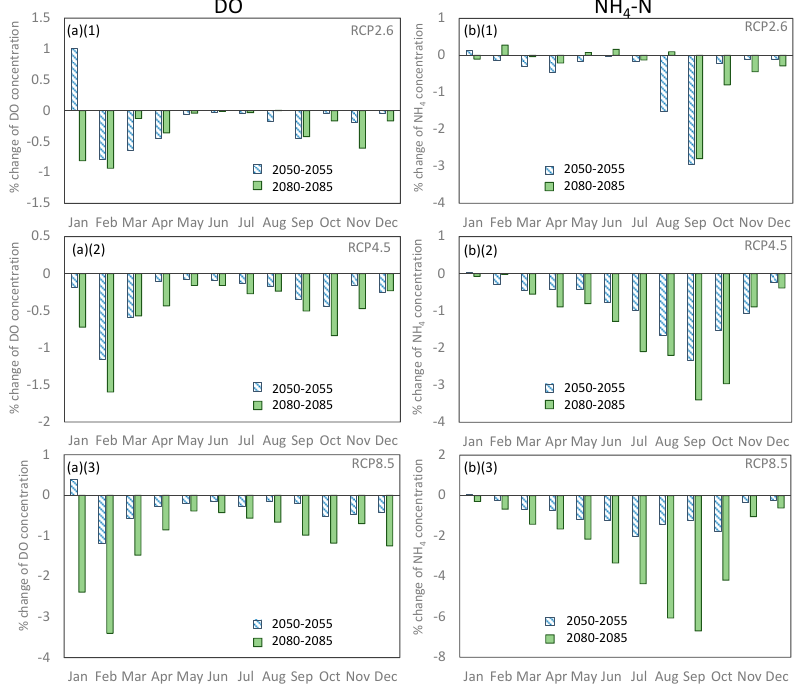
Figure 10. Percent change in water quality parameter concentrations for DO and NH 4 -N, due to climate change scenarios (Representative Concentration Pathway) ( 1 ) RCP 2.6; ( 2 ) RCP 4.5; and ( 3 ) RCP 8.5 at the Tugaske location.